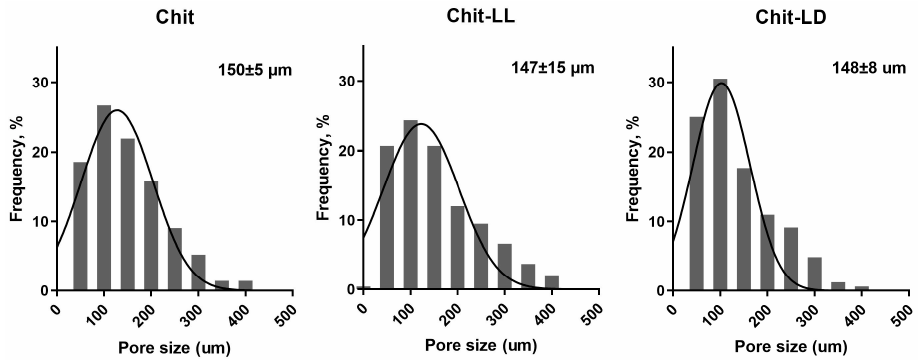
Figure 2. Pore size distribution in the macroporous hydrogel samples from chitosan (Chit) and copolymers: chitosan-g-oligo(L,L-lactide) (Chit-LL) and chitosan-g-oligo(L,D-lactide) (Chit-LD).